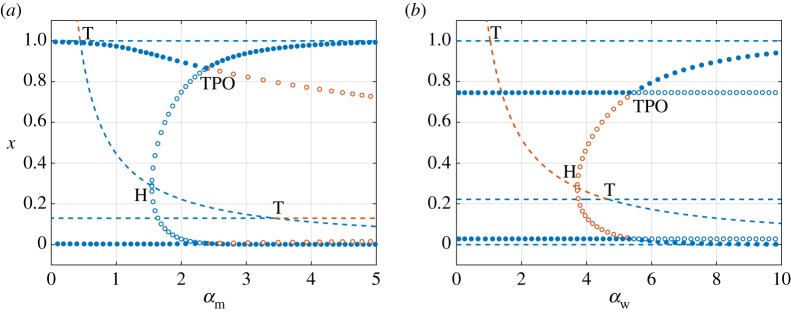
One-dimensional bifurcation diagrams for fixed values of (a) αw = 8 and (b) αm = 2, with only the x-component of equilibria (population of healthy cells) plotted for clarity. Dashed curves illustrate unstable equilibria. Filled and open markers stand for stable and unstable periodic orbits (POs), respectively. Only the maxima and minima of each PO is shown. Blue denotes biologically meaningful solutions and POs (strictly positive values for all components). Orange describes biologically meaningless solutions with negative components. Parameter values are given in (3.12). The letter T represents a transcritical bifurcation of equilibria, H a Hopf bifurcation, and TPO a transcritical bifurcation of POs.